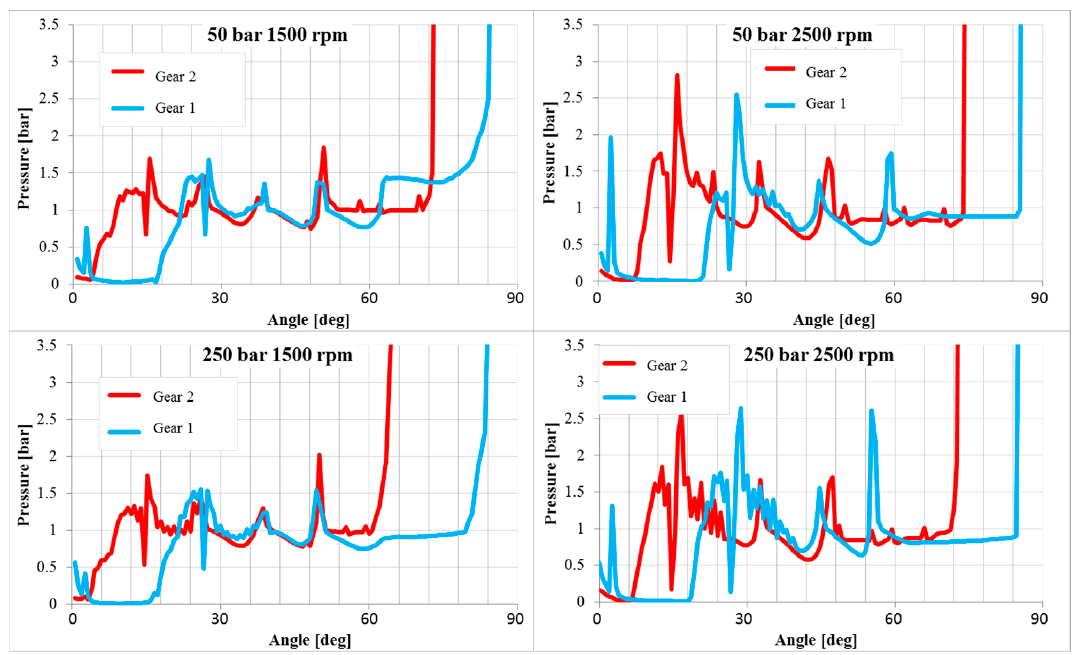
Figure 16. Pressure evolutions for two pressure levels in the range 0–3.5 bar, at T oil of 50 °C.